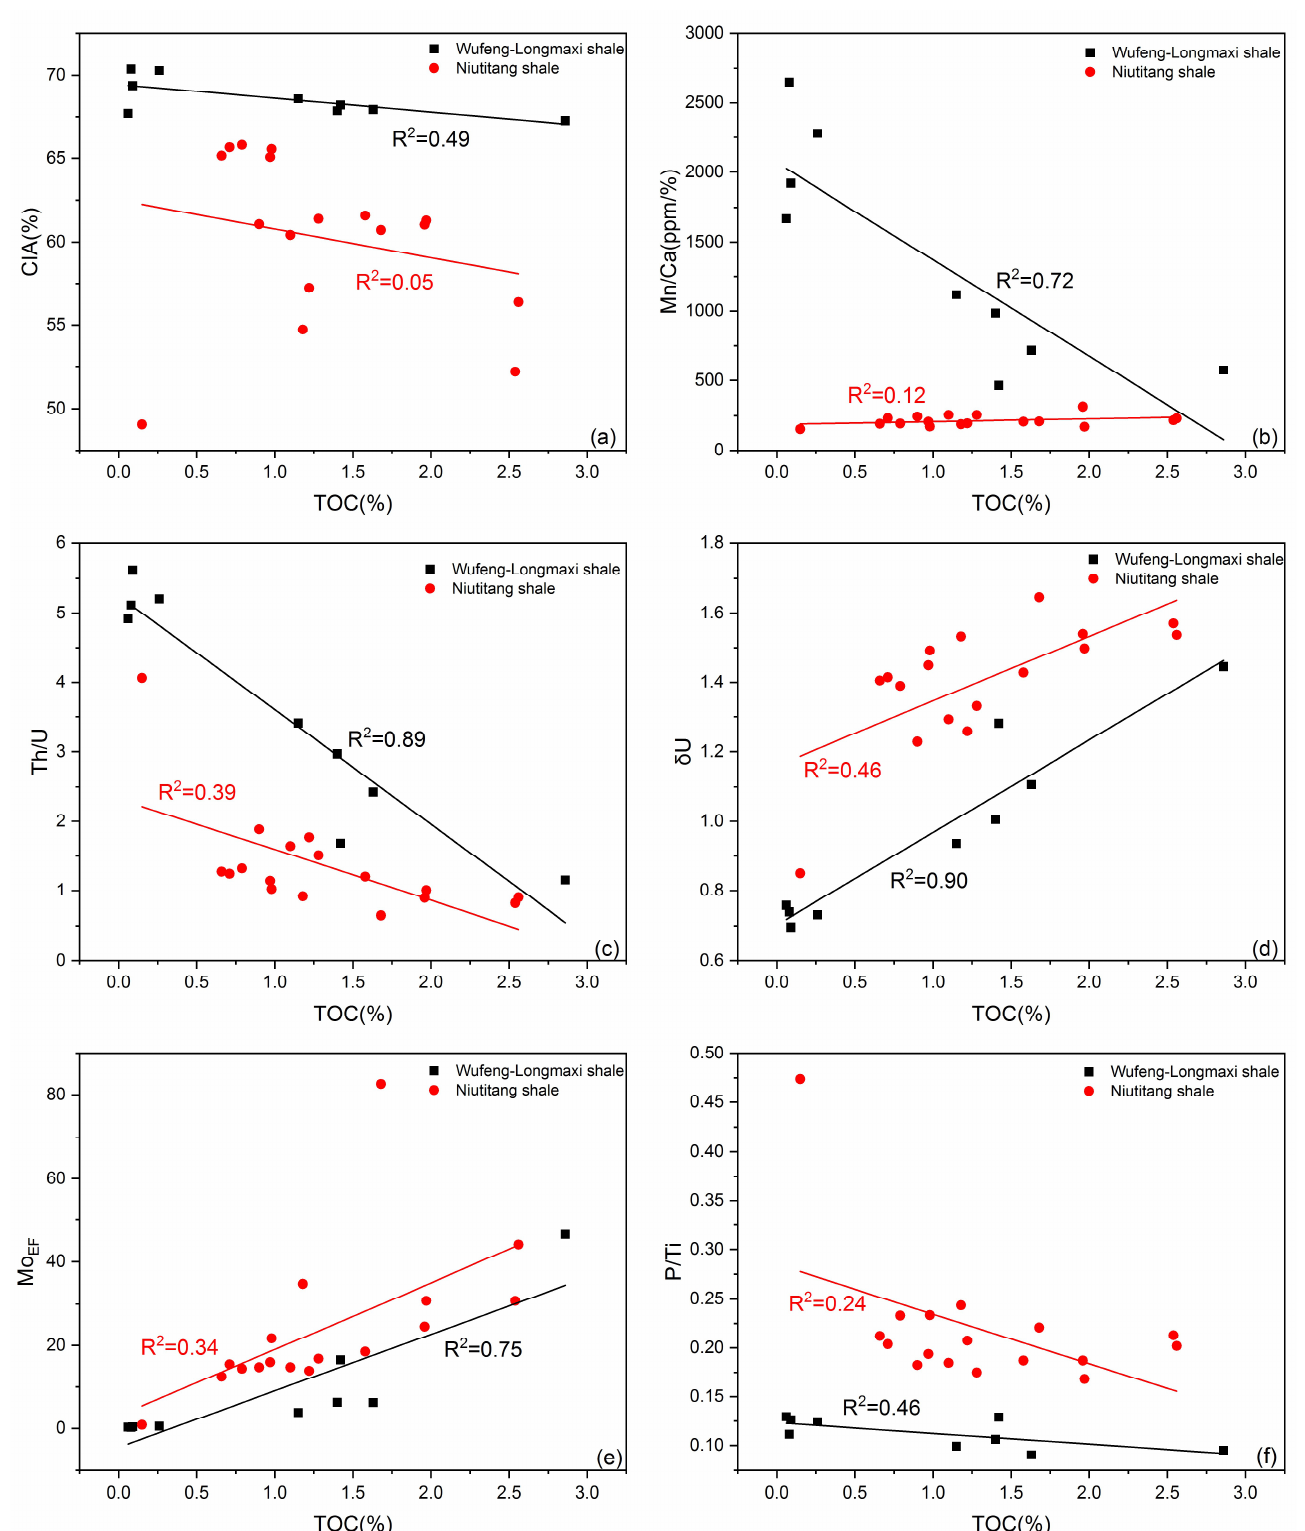
Figure 9. The relationship between different inorganic geochemical proxies and TOC